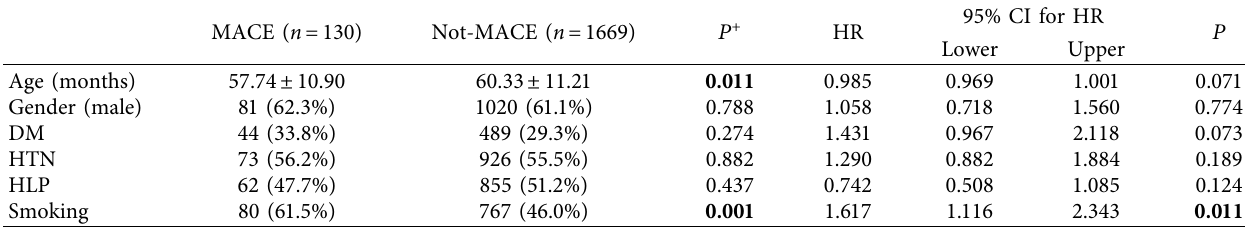
Table 2: Comparison of different variables between MACE and not-MACE groups.